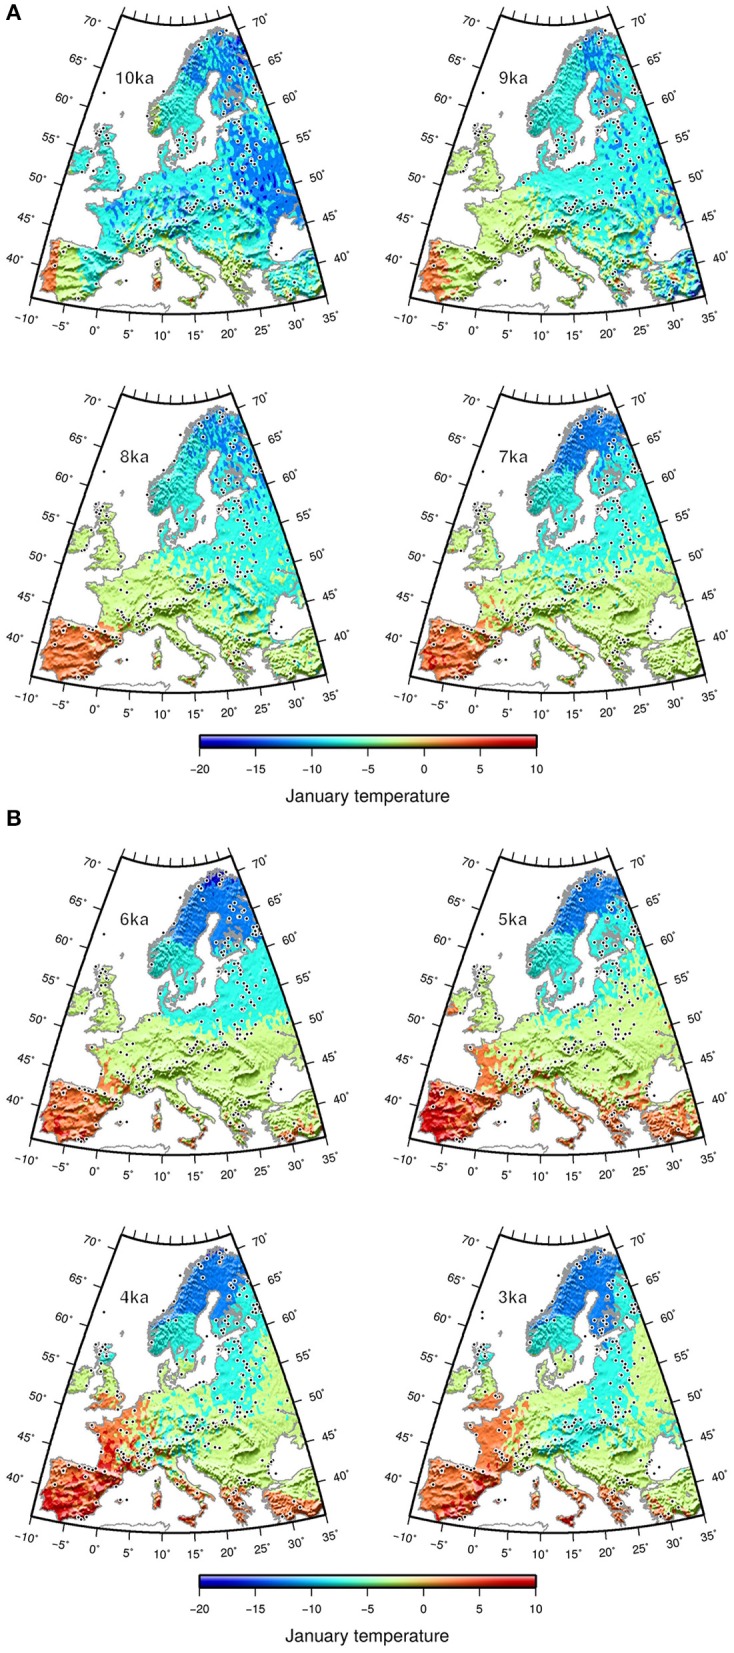
Interpolated reconstructed mean January temperature (A) from 10 to 7 ka and (B) from 6 to 3 ka from fossil pollen data (black dots).